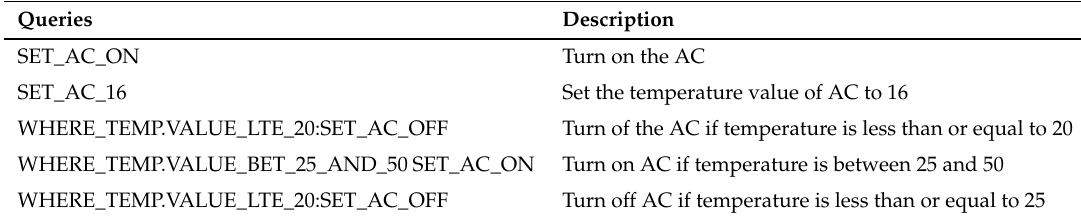
Table 5. Example of NINQ Commands with